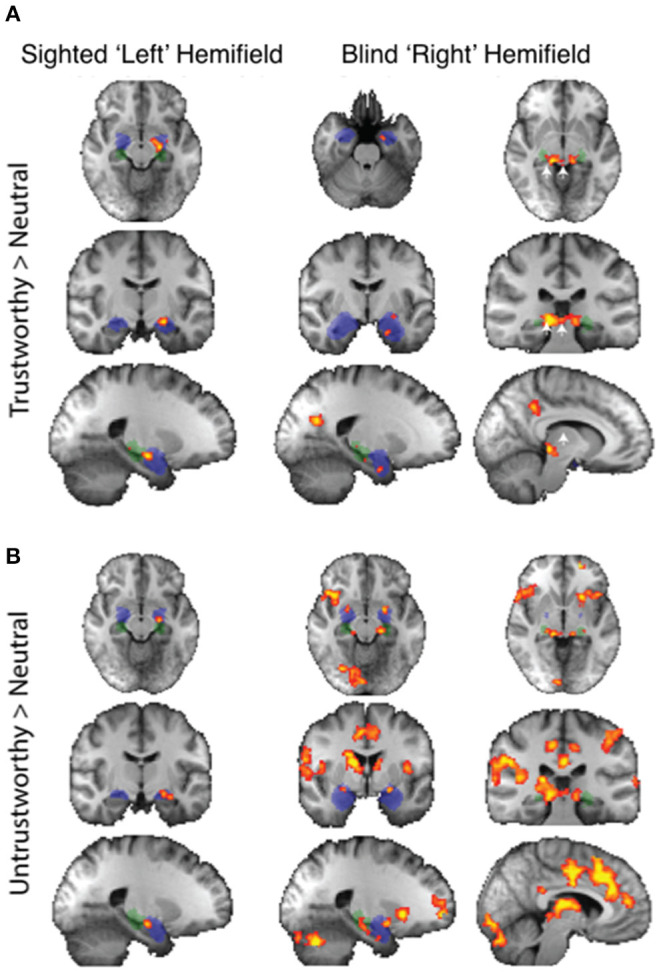
fMRI preference for trustworthiness traits > neutral in patients with blindsight. (A) Upper panel shows activity for trustworthy faces > neutral in the sighted (left column) or blind fields (right two columns). (B) Lower panel shows equivalent activity for untrustworthy faces > neutral. Fixed-effects analyses, P < 0.001 uncorrected for a priori regions of interest, elsewhere cluster corrected p < 0.01. Shaded blue areas are binarized Jülich-defined probabilistic maps of the amygdala, Jülich-defined LGN masks are green, and the superior colliculus is indicated by white arrows. Z-statistic range 2.3–4, radiological convention.